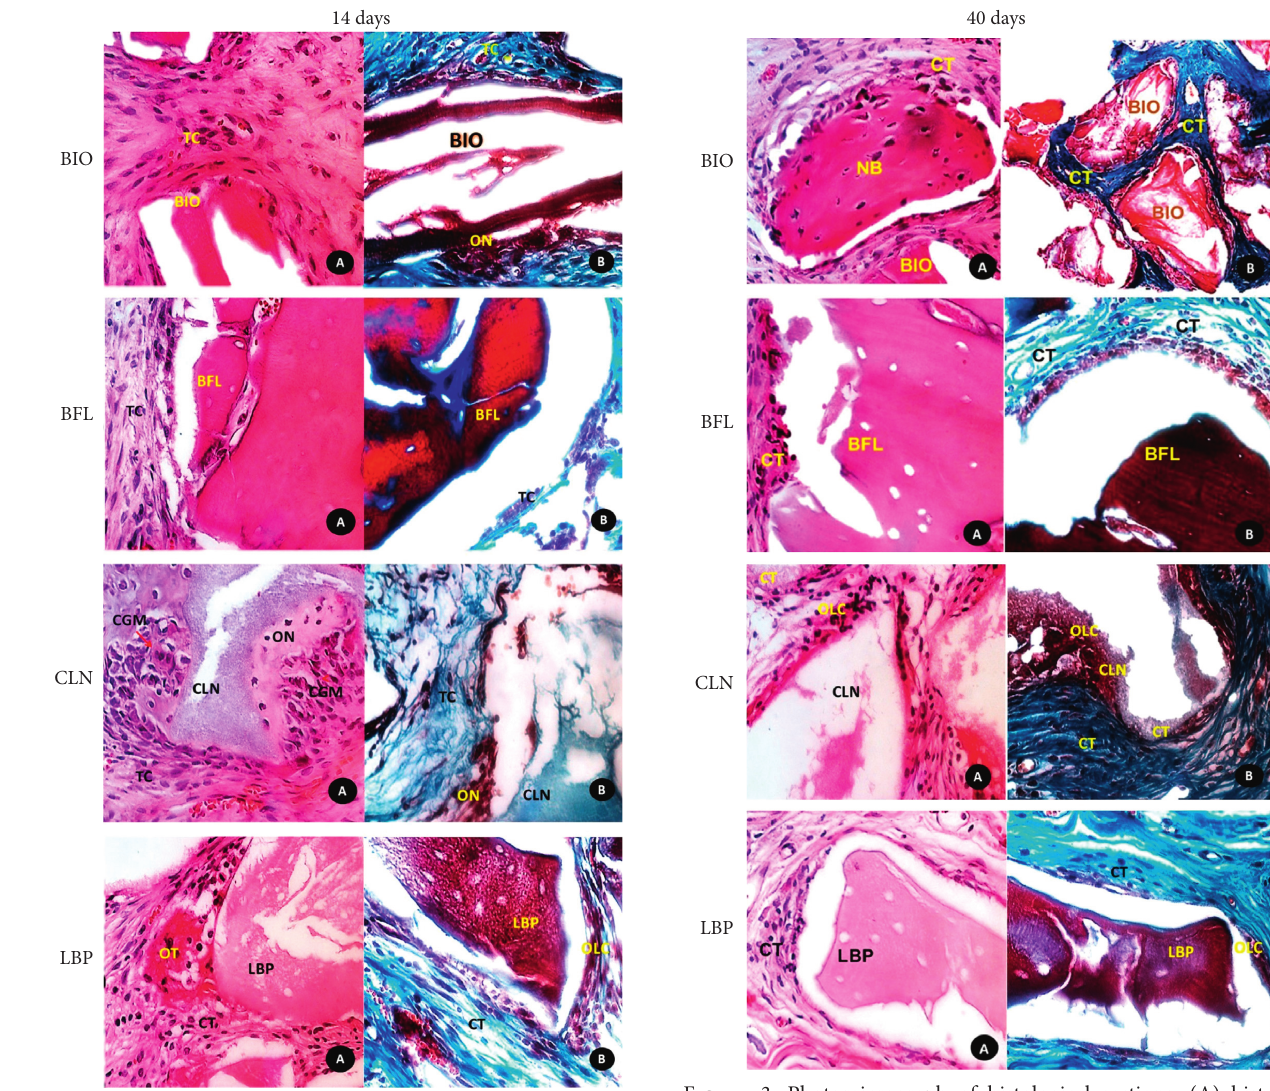
Figure 2: Photomicrograph of histological sections: (A) histo- logical detailed features of the biomaterials (BIO, BFL, CLN, and LBP) and surrounding tissues in the central region of the defect at 14 days (HE, original magnification 40x); (B) mallory trichrome staining (original magnification 40x). CT: connective tissue; NB: newly formed bone; OLC: osteoblastic line cells; OT: osteoid tissue.